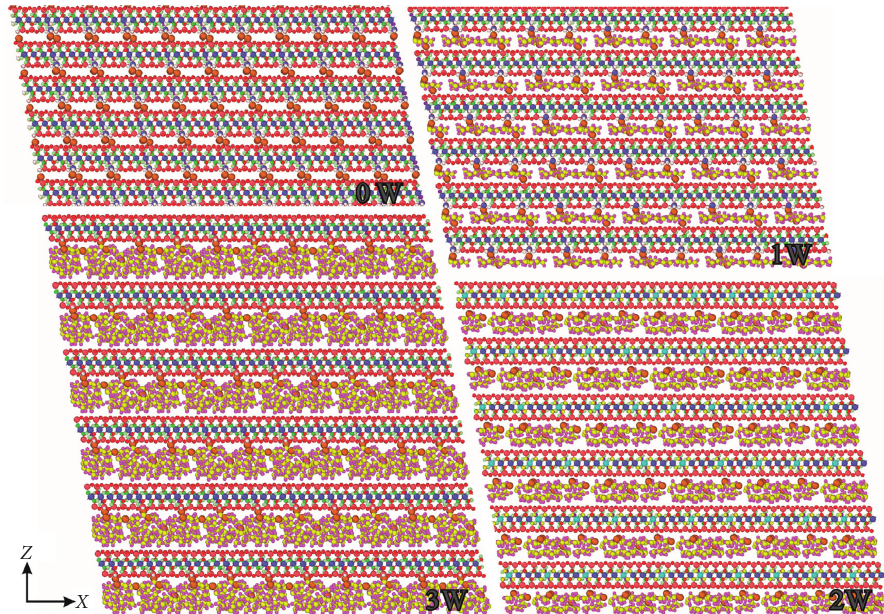
Figure 2: MD simulation snapshots showing the four different simulation cells used to study hydrated